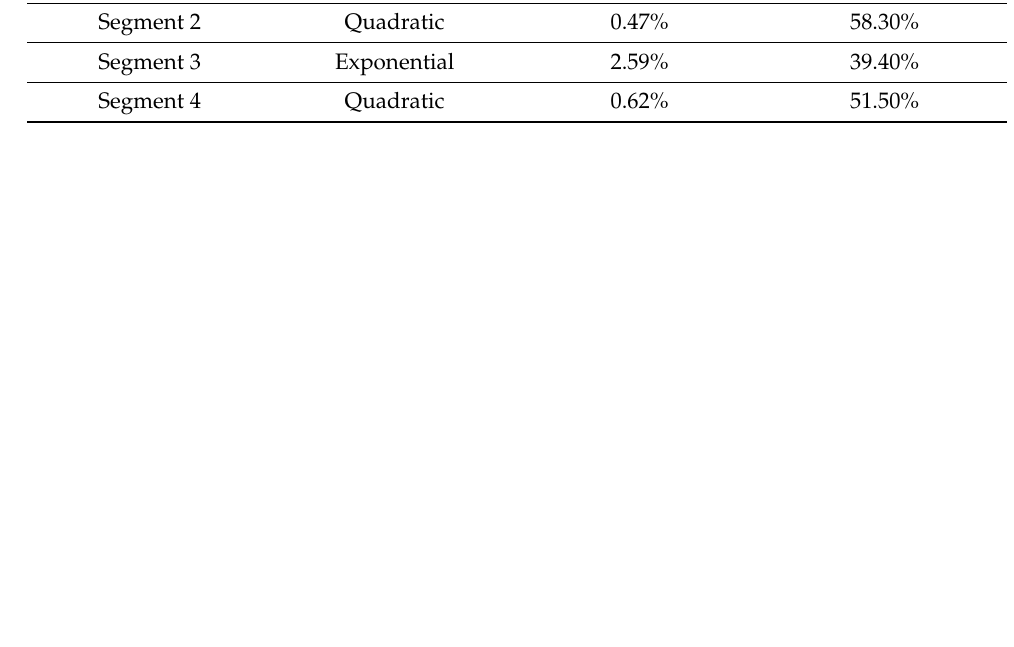
Table 6 . 22 month Lorenz curve calibration statistics.